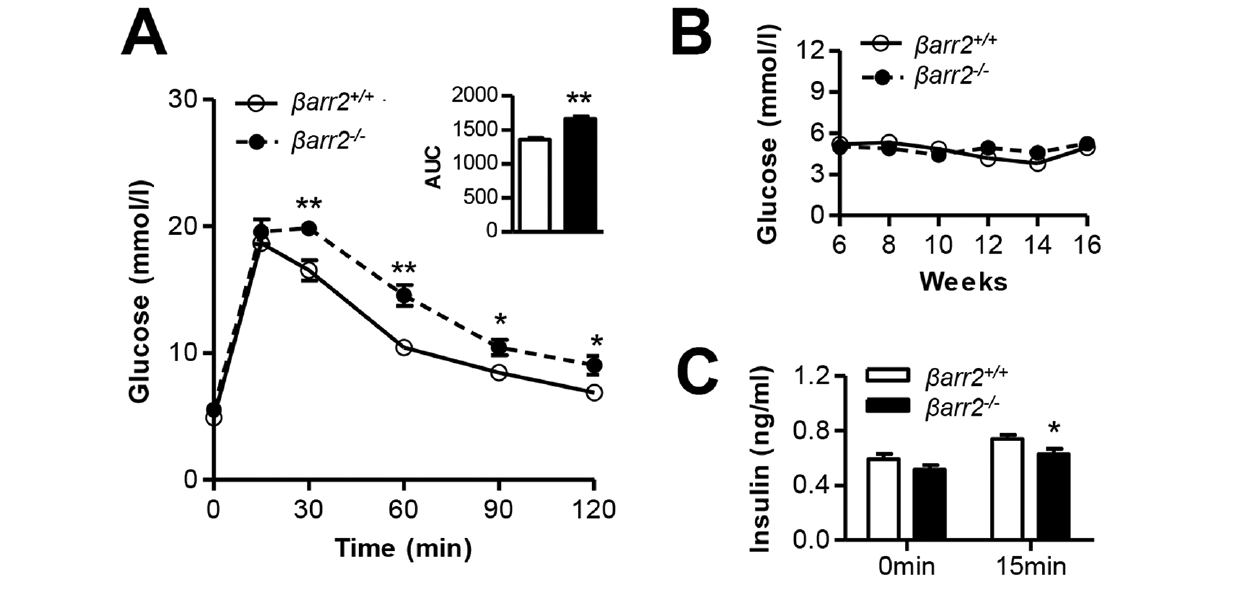
Figure 1. β arr2 deficiency results in impaired glucose metabolism and glucose-stimulated insulin secretion in mice under HFD. (A) GTT from 16-wk-old HFD-fed MIP-TF- b arr2 +/+ and MIP-TF- b arr2 –/– mice (n = 6). Insets, area under the curve during GTT. (B) Fasting glucose levels of MIP- TF- b arr2 +/+ and MIP-TF- b arr2 –/– mice fed a HFD. (C) Fasting insulin levels and 15 min after glucose-stimulated insulin secretion levels of 16-wk-old HFD-fed MIP-TF- b arr2 +/+ and MIP-TF- b arr2 –/– mice (n = 8). * P < 0.05, ** P < 0.01, versus MIP-TF- b arr2 +/+